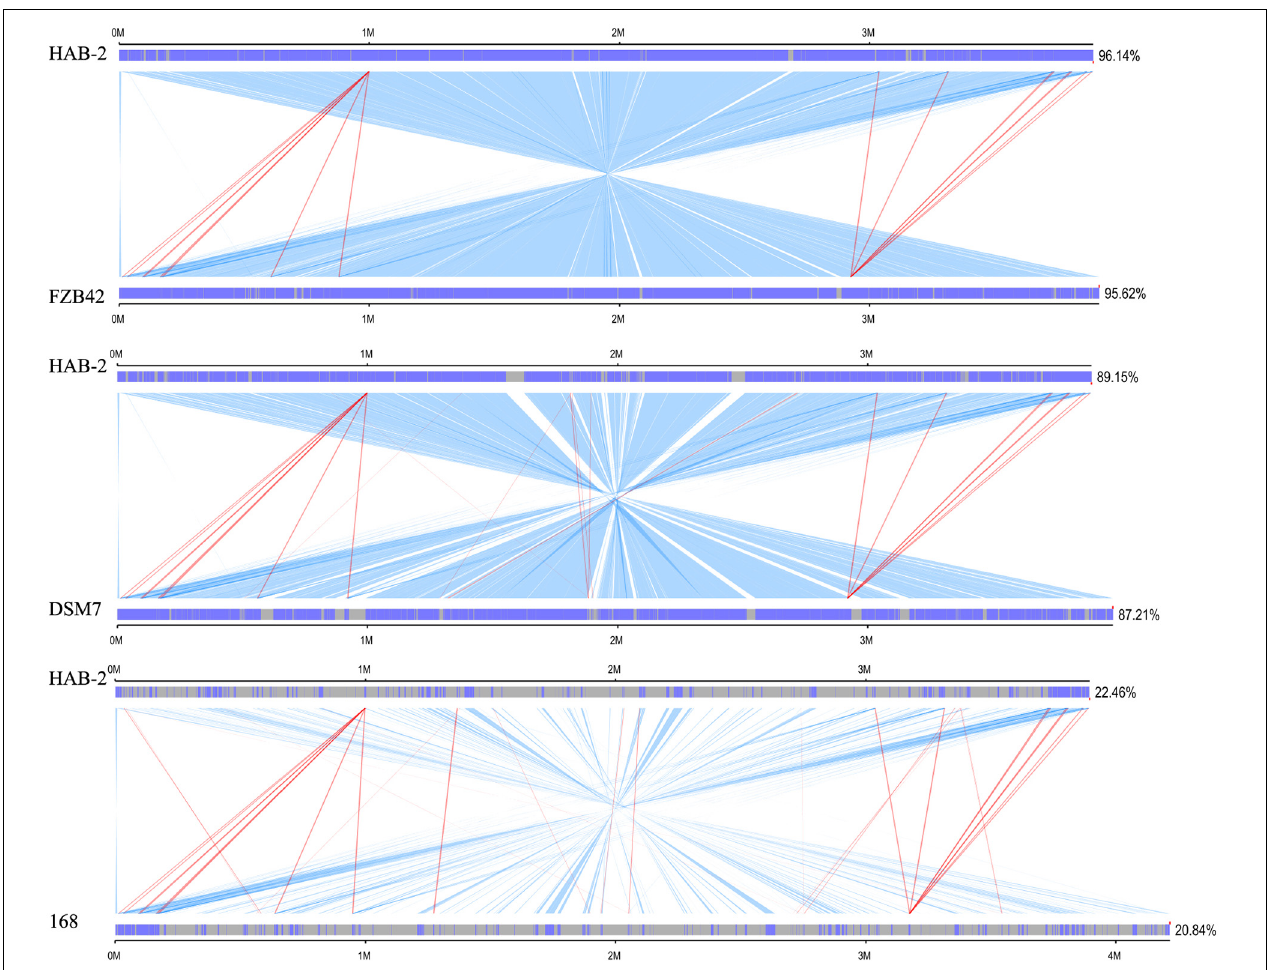
FIGURE 5 | Global alignment of B. velezensis HAB-2 and Bacillus spp. chromosomes. Indels are depicted by gray rectangles. Dark blue indicates a sequence with synteny, red indicates forward collinearity and light blue indicates negative collinearity.